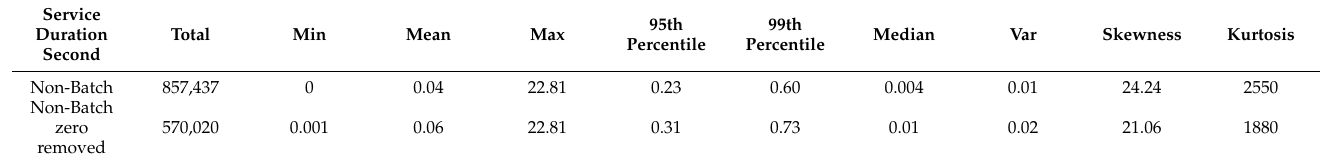
Table 15. Non-batch by category measures of dispersion.